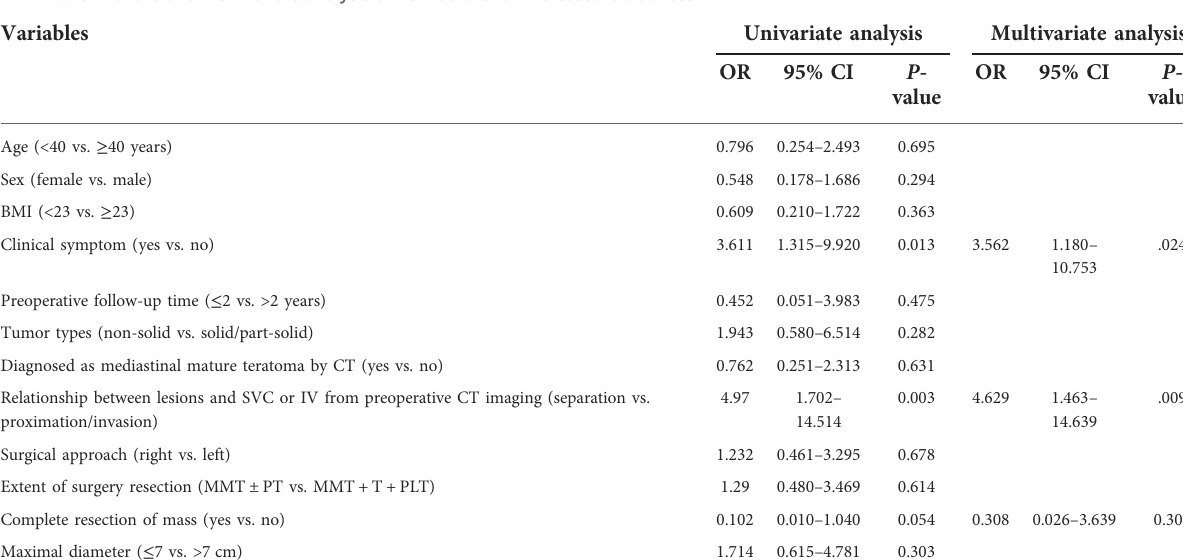
TABLE 6 Univariate and multivariate analysis of risk factors for increased blood loss.